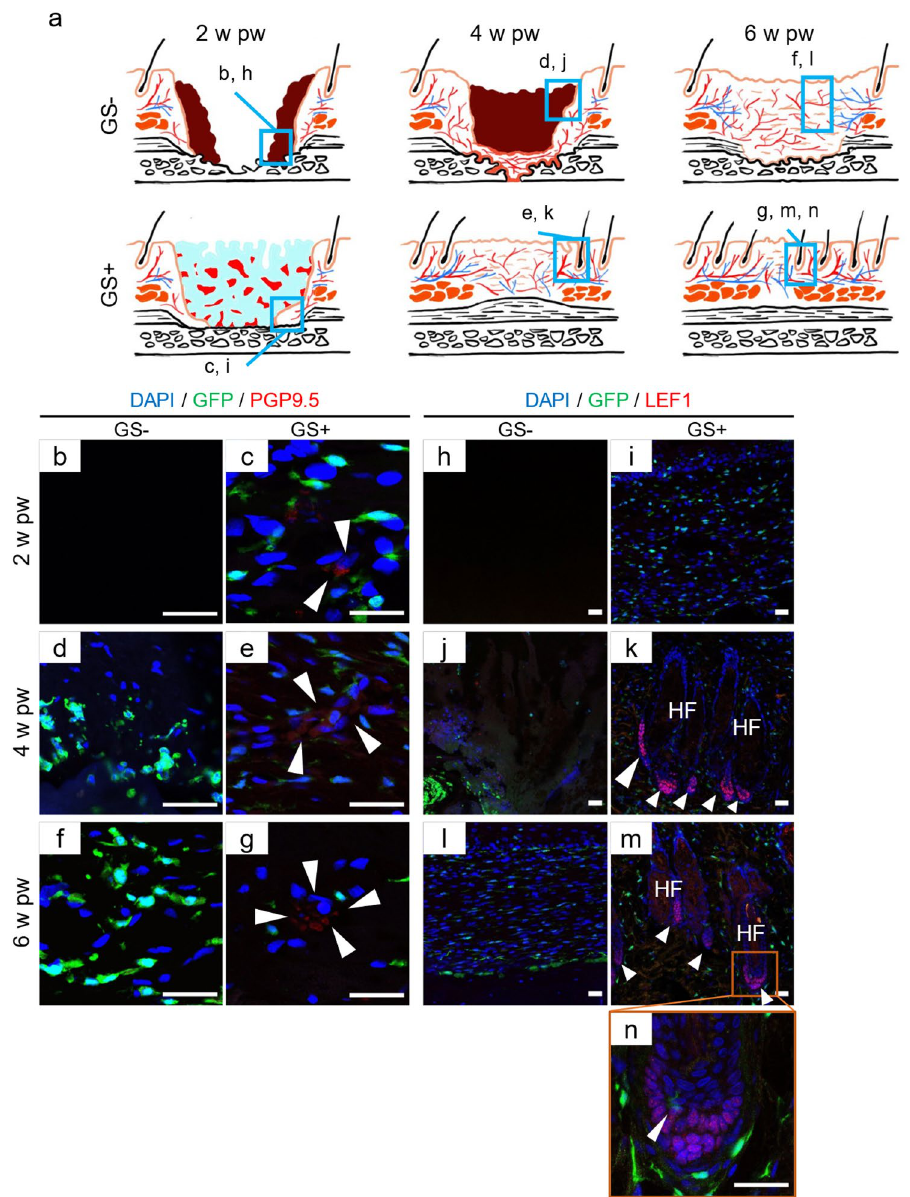
Figure 4. GS allows regeneration of nerves and appendages of the skin. ( a ) Schematic drawings of the deep wounds with or without GS application is shown at various time points. ( b – g ) PGP 9.5 (red)-positive cells (arrowheads) are scattered at 2 w pw and commence to form assemblies after 4 w pw in GS (+) rats but not in GS (−) rats. ( h – n ) Lef1 (red) is positive in the dermal papilla of de novo hair follicles (arrowheads) after 4 w pw in GS (+) rats but not in GS (−) rats. ( n ) High-power view showing that BMDCs are Lef1-negative. n = 4 for each. The experiments were repeated twice. HF hair follicles, Scale bars, 30